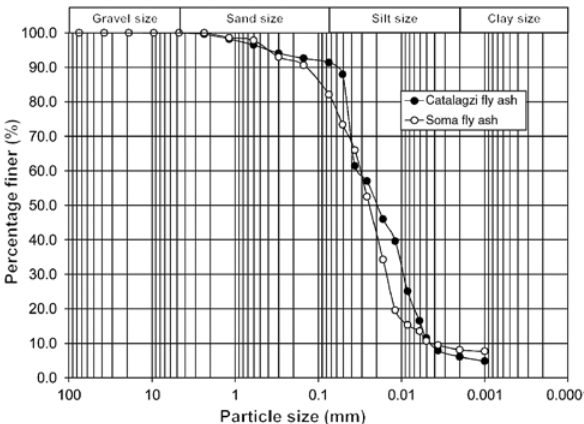
Figure 3: Particle size distribution of fly ashes.